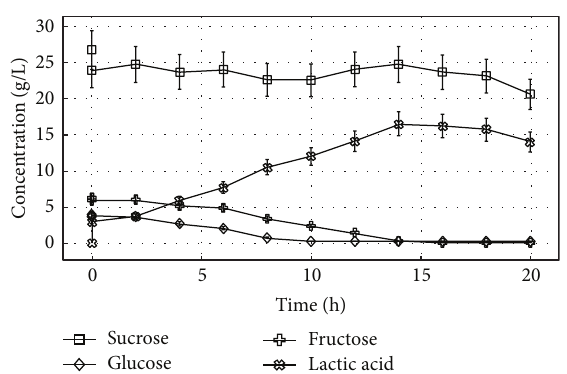
Figure 1: L. rhamnosus ATCC 10863 fermentation overview: sugars consumption and lactic acid production at batch fermentation proc-